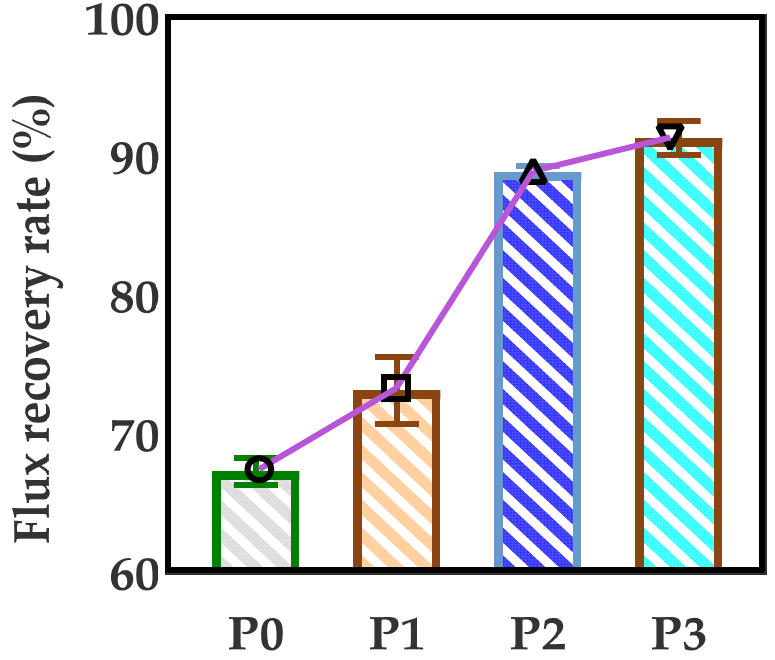
Figure 15. Flux recovery rate of PA66/GO membrane varies with GO content.